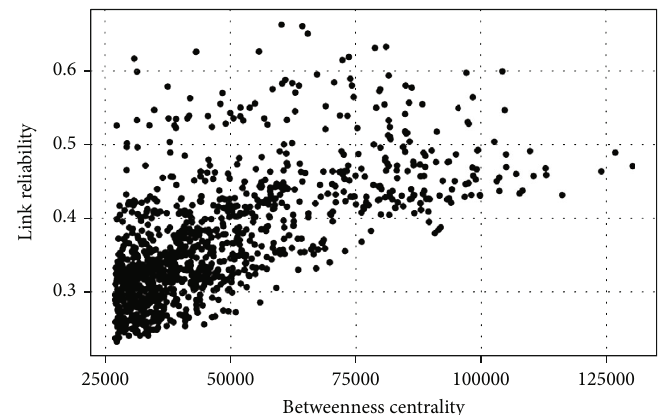
Figure 9: Relationship between lr